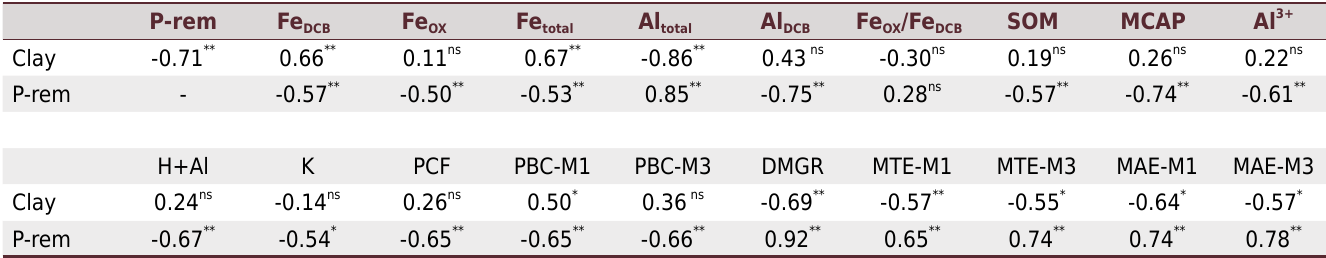
Table 3. Pearson’s simple linear correlation coefficients between P-remaining and clay with soil attributes related to the buffering capacity of P